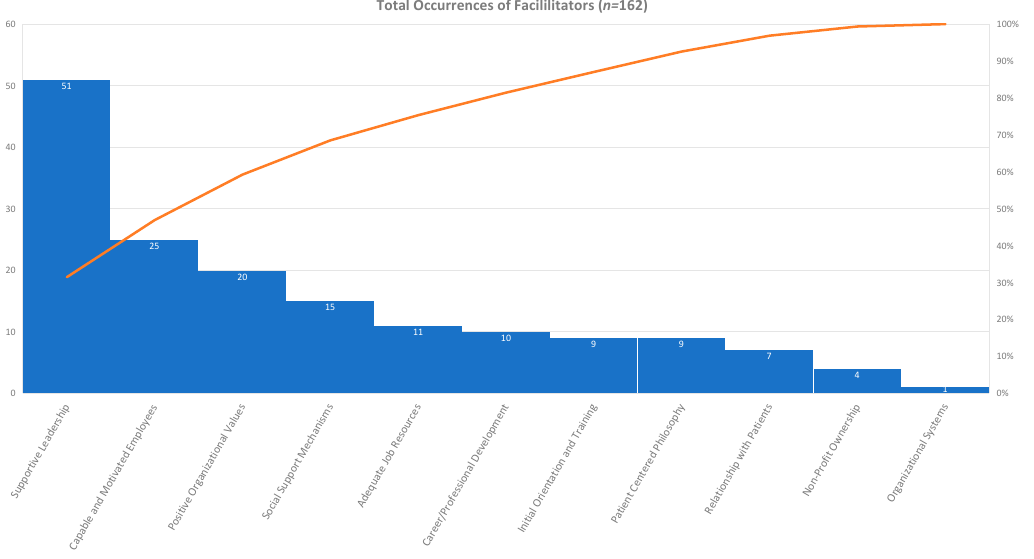
Figure 2. Total occurrences of facilitators in the review with the first four facilitators comprising 68.52% of the occurrences.